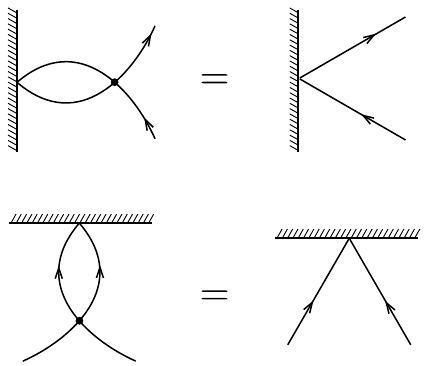
Figure 24 . The boundary crossing relation and the Watson equation. The boundary crossing relation in the re(cid:13)ection picture (the upper (cid:12)gure) is equivalent to the Watson equation in the form factor picture (the lower